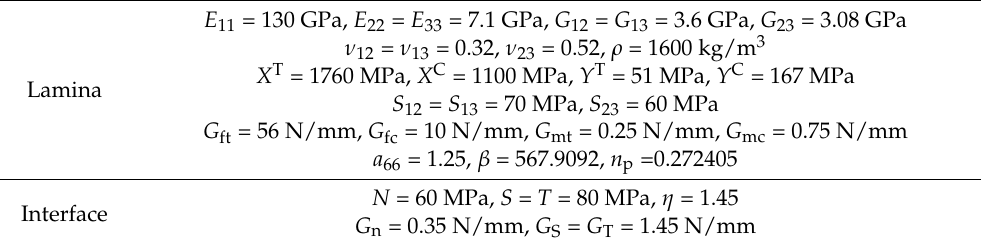
Table 1. Material properties of composite lamina and interface [22].